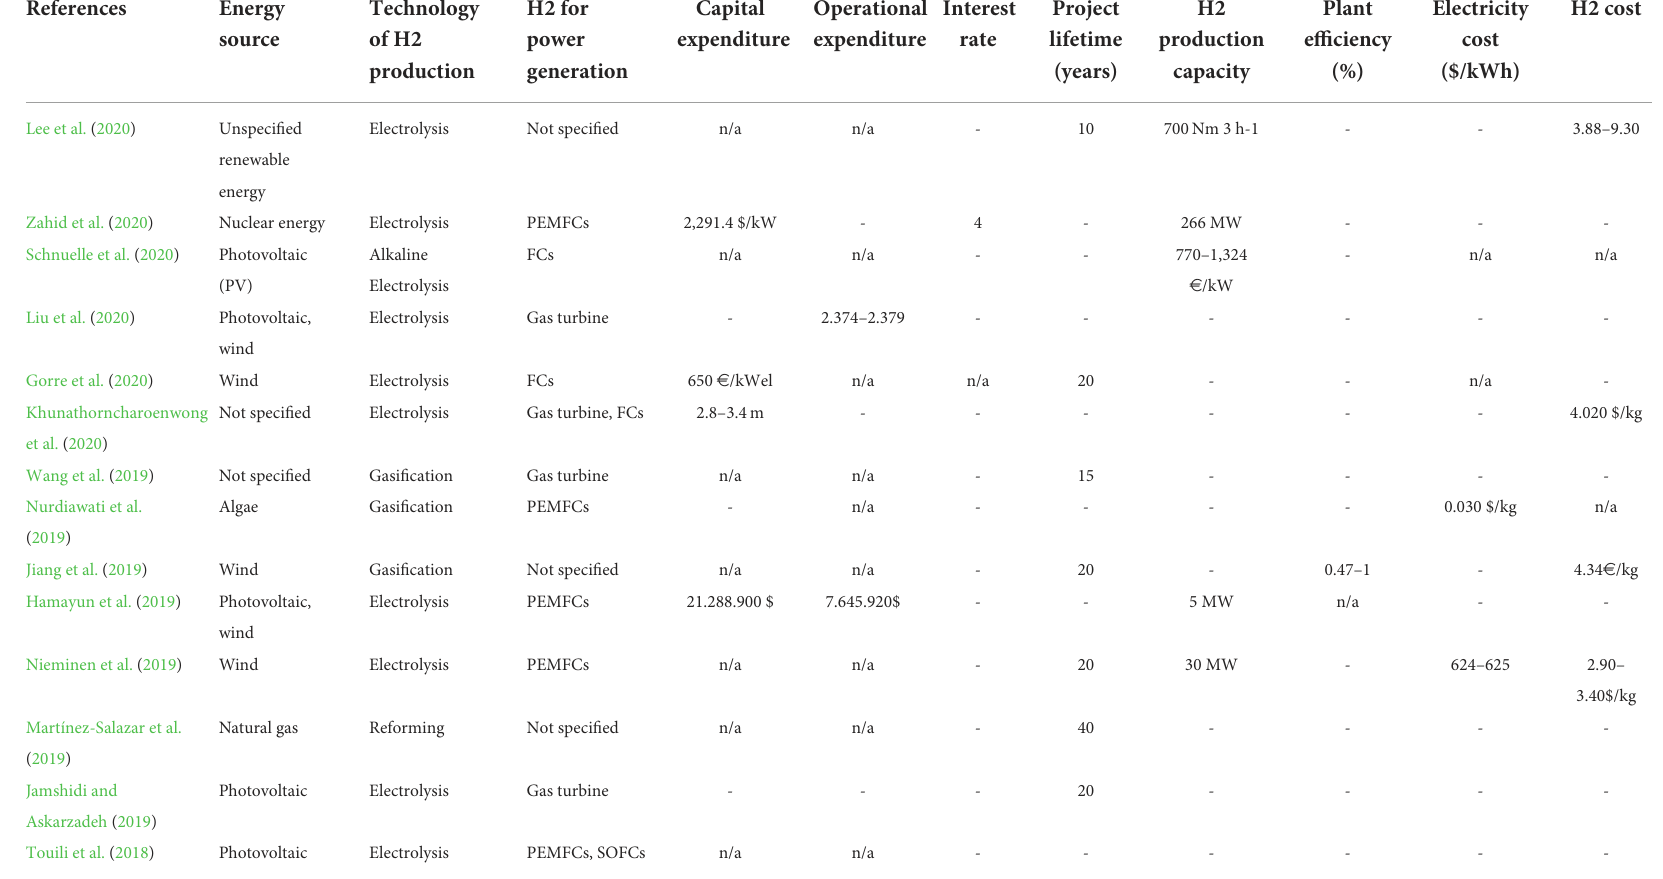
TABLE 2 Summary economic of hydrogen